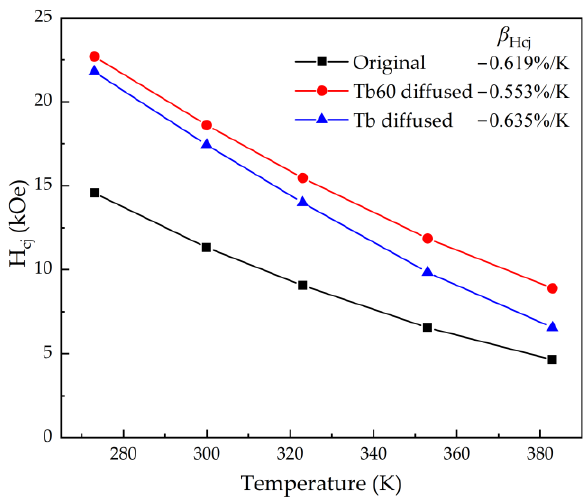
Figure 7. The temperature dependence of the coercivities for the original and the Tb60 and Tb diffusion magnets.